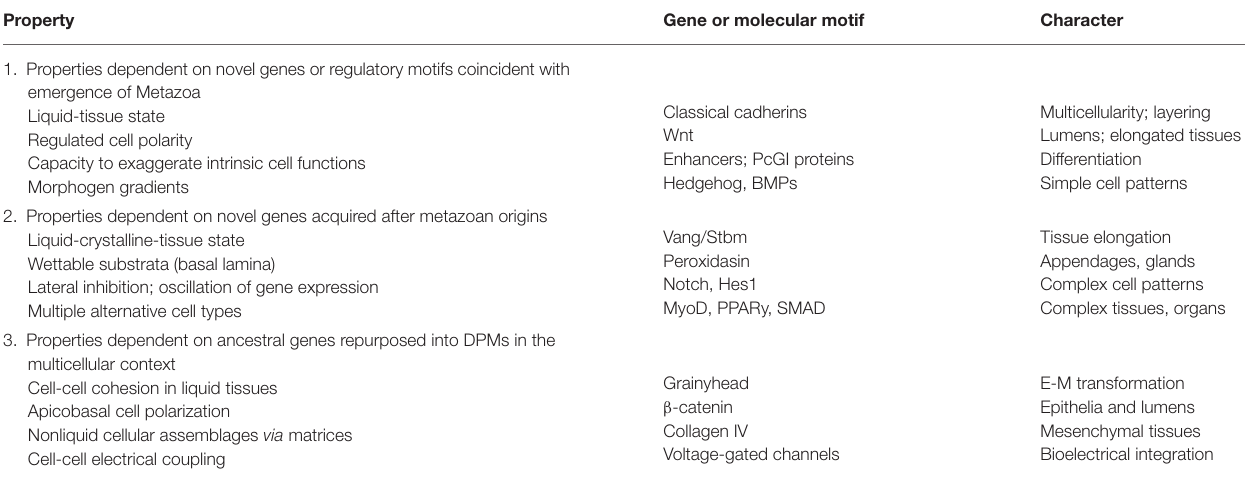
TABLE 1 | Novel inherent properties in animal development and